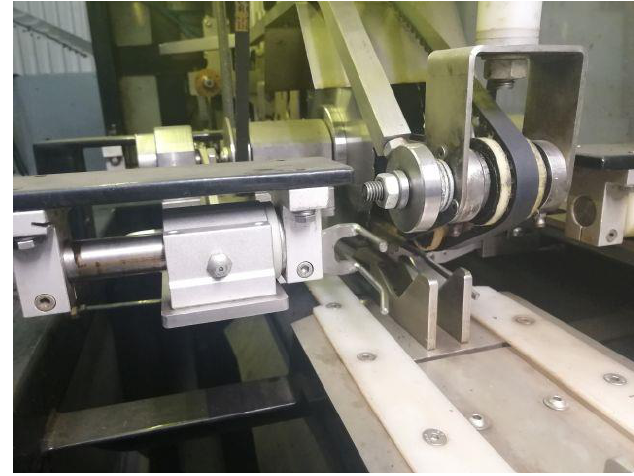
Figure 5. Onion tip cutting system, indicated by the number 4 in Figure 3.